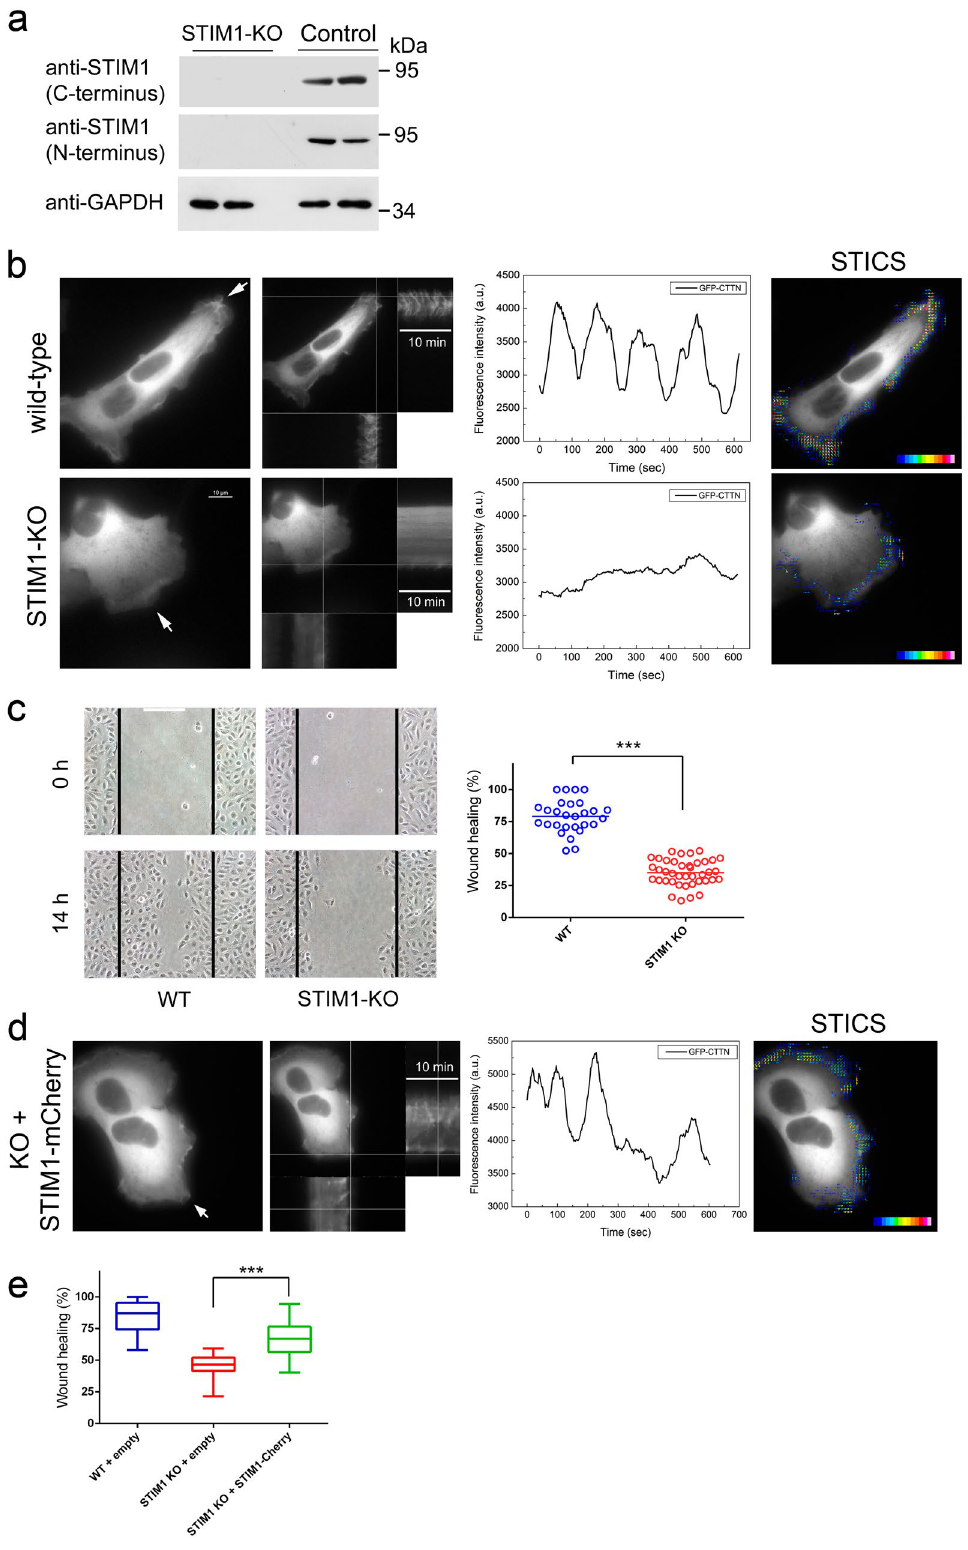
Figure 4. Knock-out of STIM1 expression by CRISPR/Cas9 D10A gene editing. Gene editing was performed in U2OS cells following the strategy presented in Supplementary Fig. 1. ( a ) STIM1 expression was assessed using antibodies against C-terminal and N-terminal epitopes. GAPDH was used as loading control. ( b ) Top panels. 1: wild-type cells were transfected for the transient expression of GFP-CTTN, and monitored for 10 min at 37 °C (image acquisition every 3 sec). Assay medium was Leibovitz’s L-15 + 10% FBS. 2: Orthogonal projections of the areas marked show the fluorescence intensity over the time (10 min) (kymograph). 3: GFP-CTTN